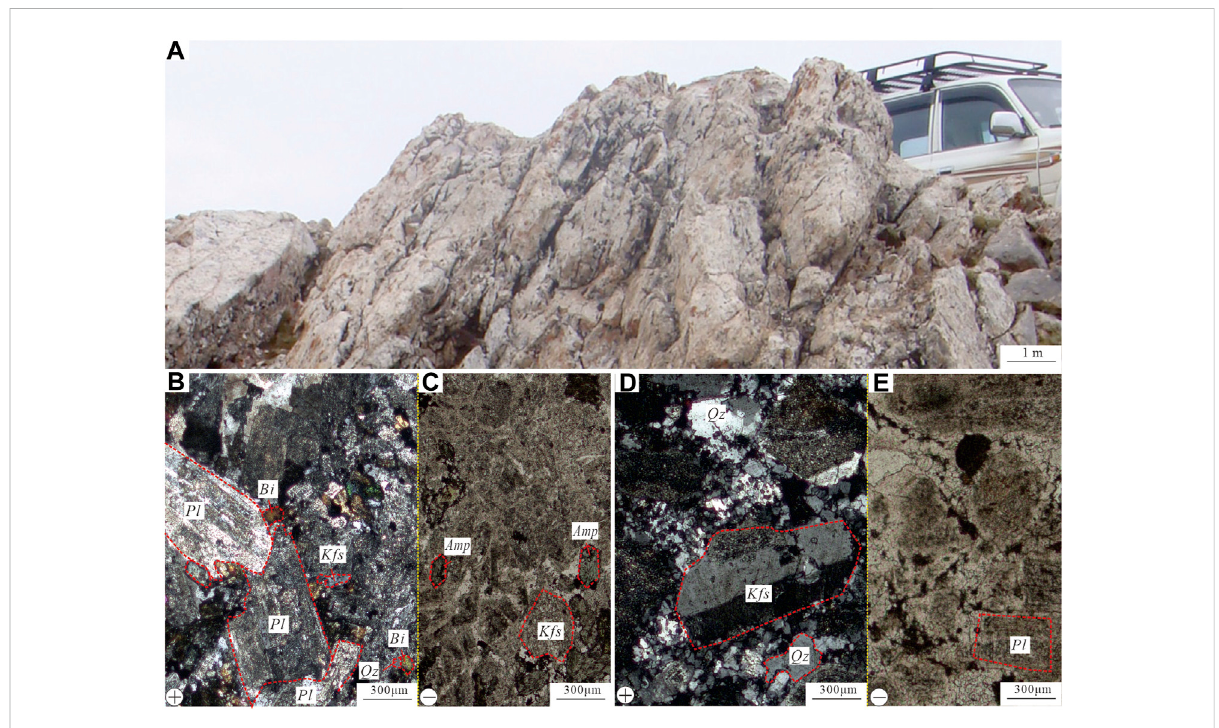
FIGURE 3 Petrographic characteristics of the rocks in Budongla. (A,B) : The fi eld outcrops of the mmonzodiorite; (C – E) : Microphotographs in plane polarized light (-) and perpendicular polarized light (+) of the monzodiorite. Pl: plagioclase; Kfs: K-feldspar; Qz: Quartz; Bi: Biotite; Amp: